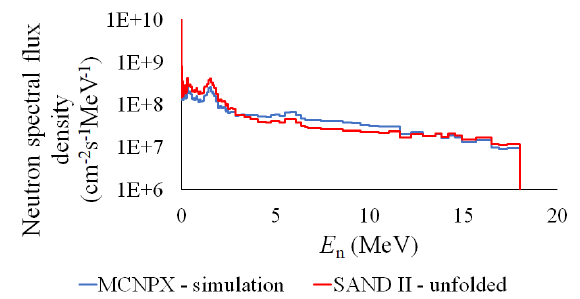
Figure 6. The unfolded and determined neutron energy spectra from the source reaction p(20)+Be at the position P14. Table 4. Calculated over experimental reaction rate